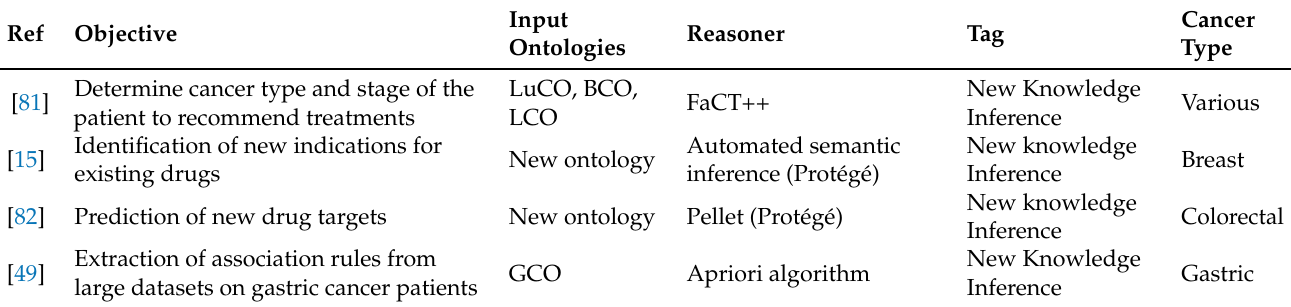
Table 3. Semantic-focused applications: reasoning with